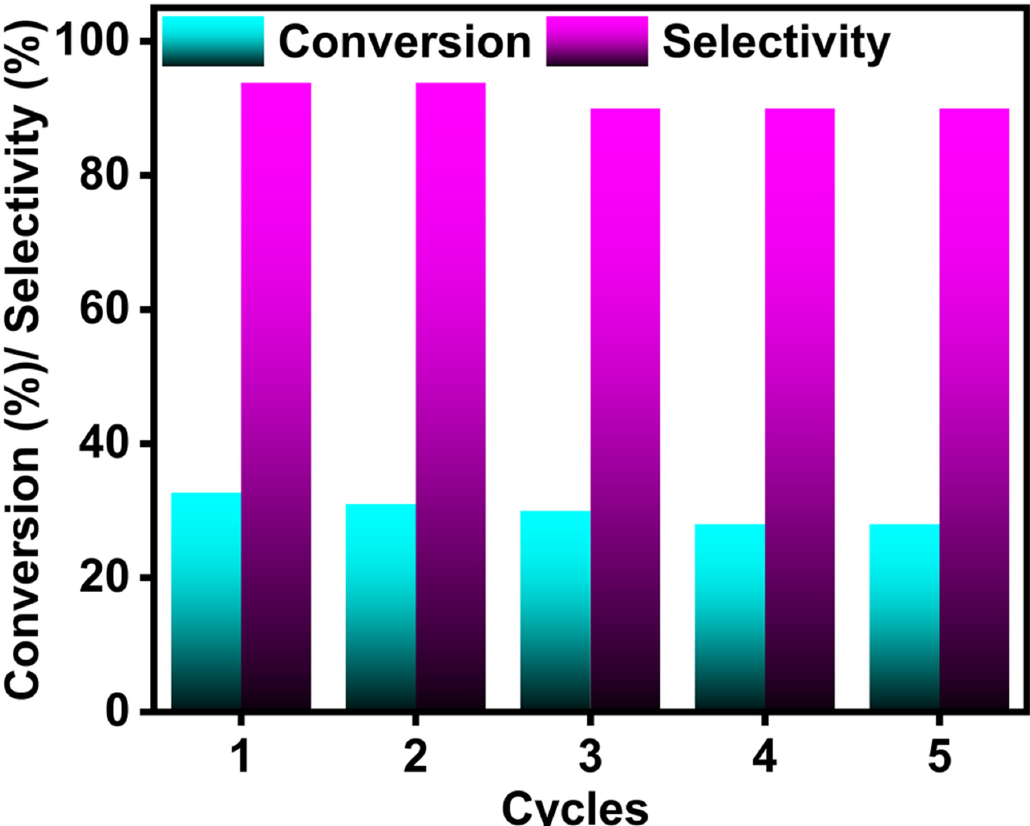
Figure 4. Recycling ability of STP − 1 catalyst in the liquid phase oxidation of styrene to benzalde- hyde.